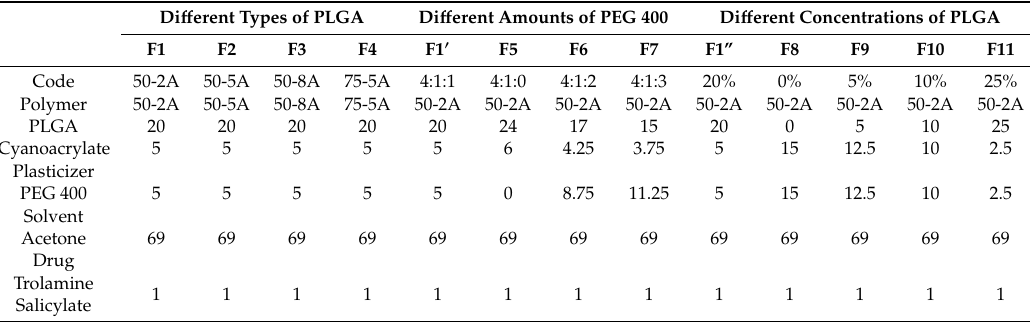
Table 2. Composition of the distinct formulations (% ( w / w